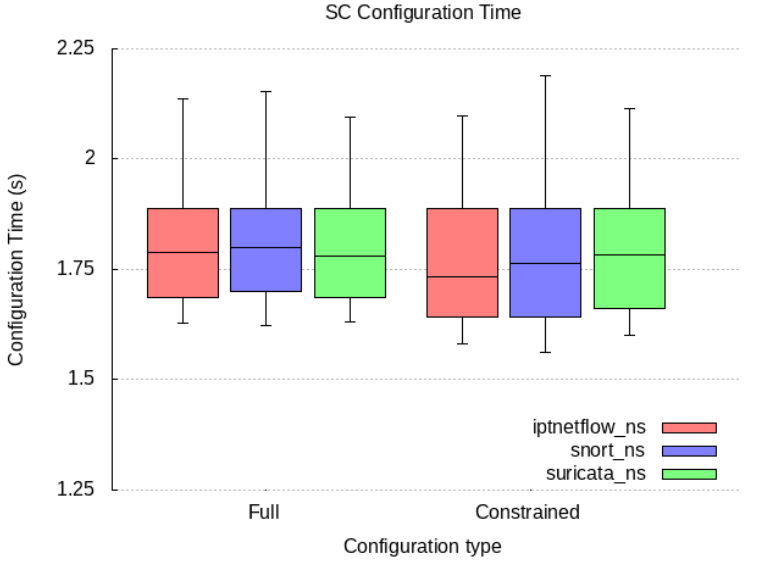
Figure 13. Distribution of configuration times for the three devised SCs, comparing full ( left ) and constrained ( right )